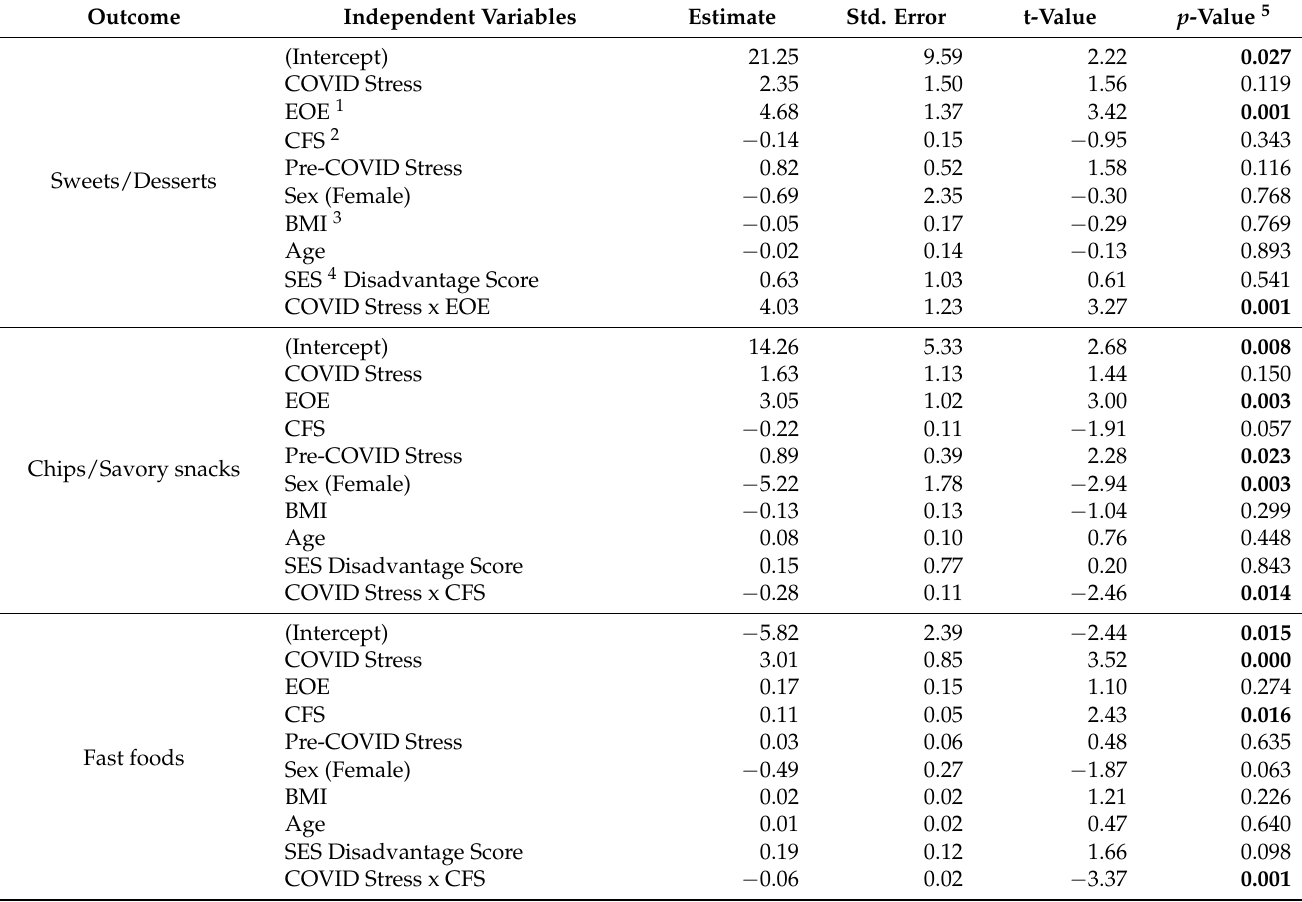
Table A1. Full final regression models from forward selection procedure with covariates ( n =